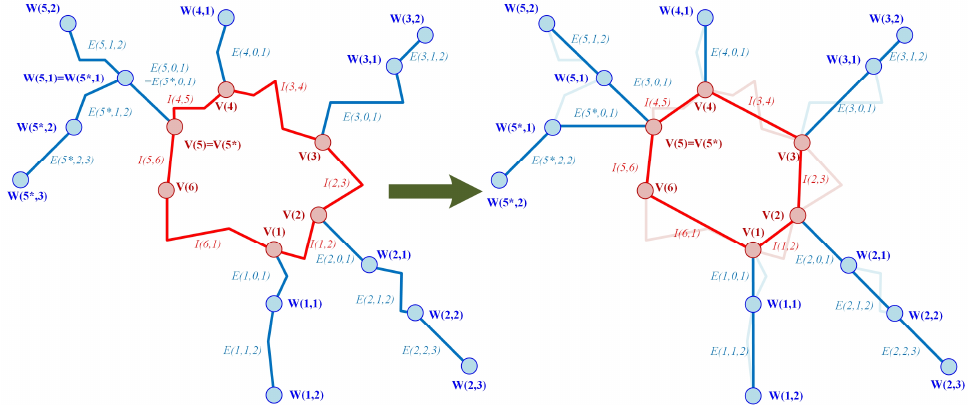
Figure 13. Geometrical model of a real city logistics system of the concentrated sets of delivery locations with slashes and then simplified, in the case of n = 6.